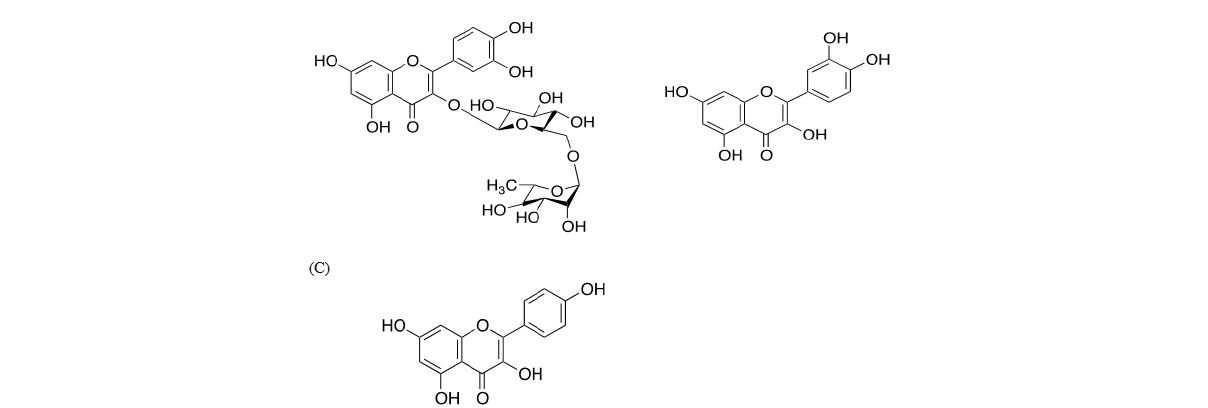
Figure 1: Chemical structures of (A) rutin, (B) quercetin, and (C)